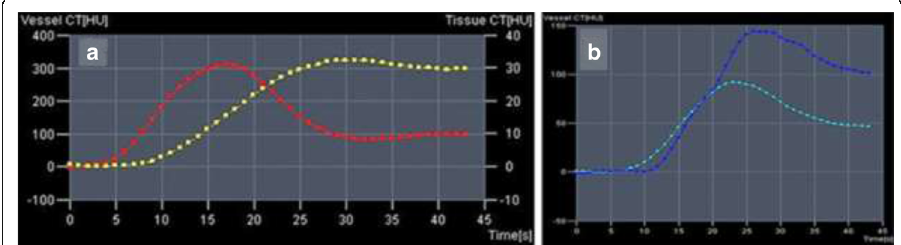
Fig. 1 Graphs of “ concentration/time ” . a Values of arterial blood flow (red curve) ROI - abdominal aorta, surrounding tissue (yellow curve). b Indicators of blood flow in the stroma of the spleen (dark blue curve) and portal vein (blue curve)